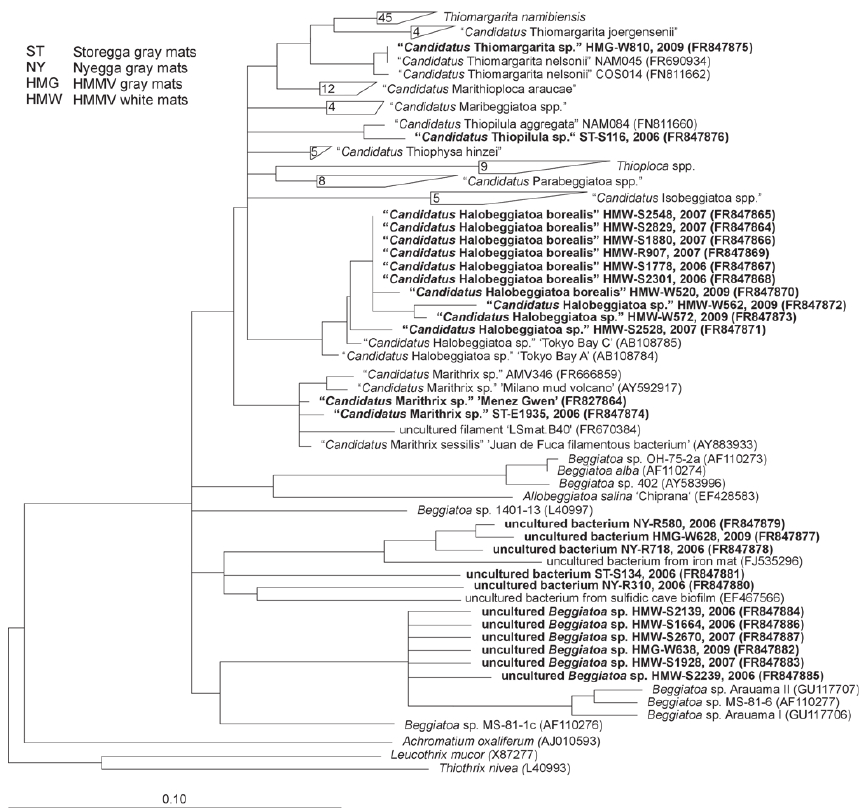
Fig. 3. Phylogenetic tree showing 16S rRNA gene sequences obtained within this study (indicated by bold type) that affiliate with the family Beggiatoaceae . Taxonomic nomenclature was adapted from Salman et al. (2011). One new genus, “ Candidatus Halobeggiatoa borealis”, is proposed based on this study. Tree reconstruction was conducted with 206 nearly full length sequences ( Escherichia coli positions 279 to 1463) by applying neighbor joining, maximum likelihood (RAxML) and maximum parsimony methods as well as different conservatory filters. Shorter sequences were added subsequently by applying parsimony criteria. Only selected sequences are shown. Unstable branching orders were visualized by multifurcation. The bar indicates 10% estimated phylogenetic